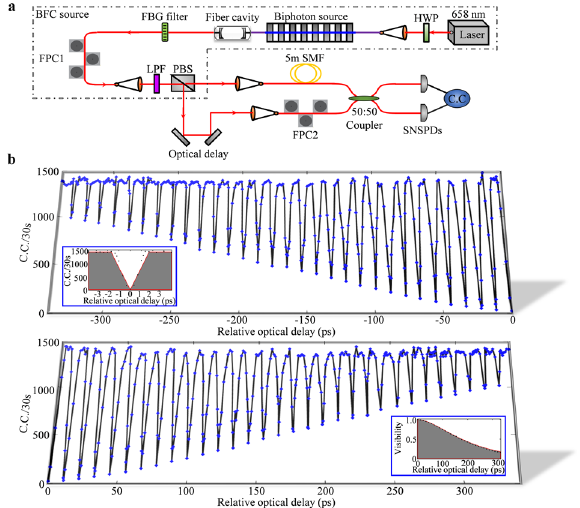
Fig. 1 High-dimensional BFC generation and HOM recurrence observation. a Illustrative experimental con fi guration. HWP half- wave plate, FBG fi ber Bragg grating, FPC fi ber polarization controller, LPF long-pass fi lter, PBS polarizing beam splitter, SNSPDs super- conducting nanowire single-photon detectors, C.C. coincidence counts. b Coincidence counts versus relative optical delay from − 340 to + 340 ps, between the two arms of the HOM interferometer. HOM-interference recurrences are observed with up to 61 time bins. Upper left inset: zoom-in of the coincidence counts around zero relative delay between the two arms of the HOM interferometer. The dip width was fi t to 3.86 ± 0.30 ps, which matches well with the reciprocal of the 245 GHz phase-matching bandwidth, as predicted by theory. The central dip visibility is 98.4% before and 99.9% after subtracting accidental coincidences. Lower right inset: measured time-bin visibilities versus the HOM optical delay compared with theory (red solid line, details in Supplementary Discussion